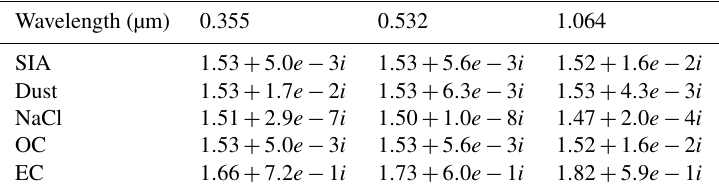
Table 1. Refractive indices at the three harmonics of the Nd:YAG laser assumed in the MATCH mass-transport optics